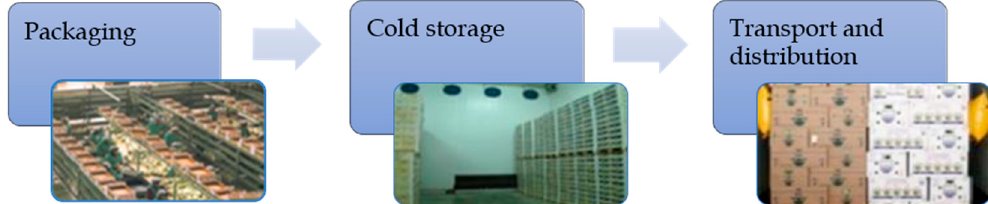
Figure 11. Stages of the postharvest supply chain used for real test of the system.